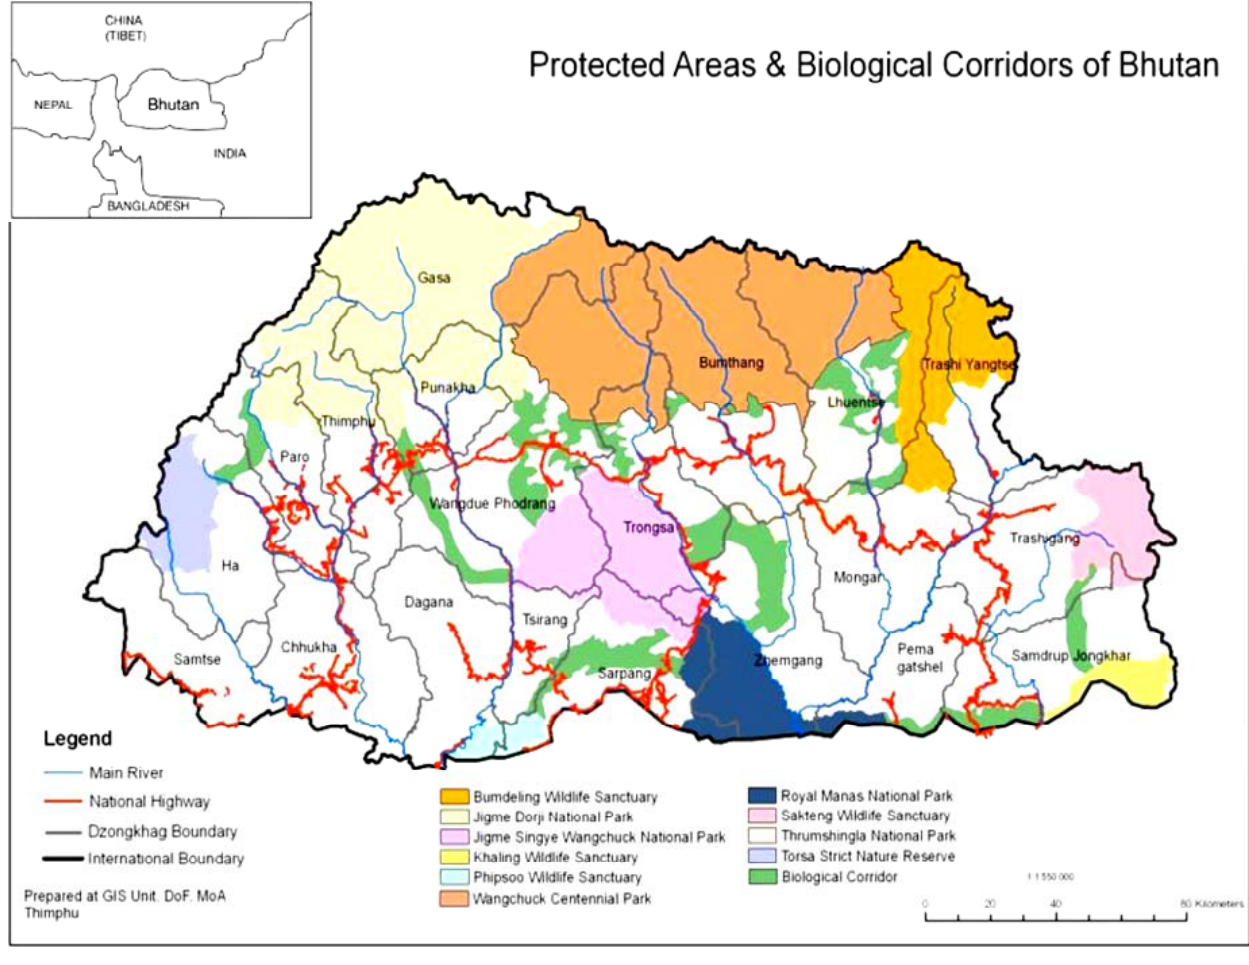
Figure 1. Protected areas of Bhutan (Courtesy of Phuntsho